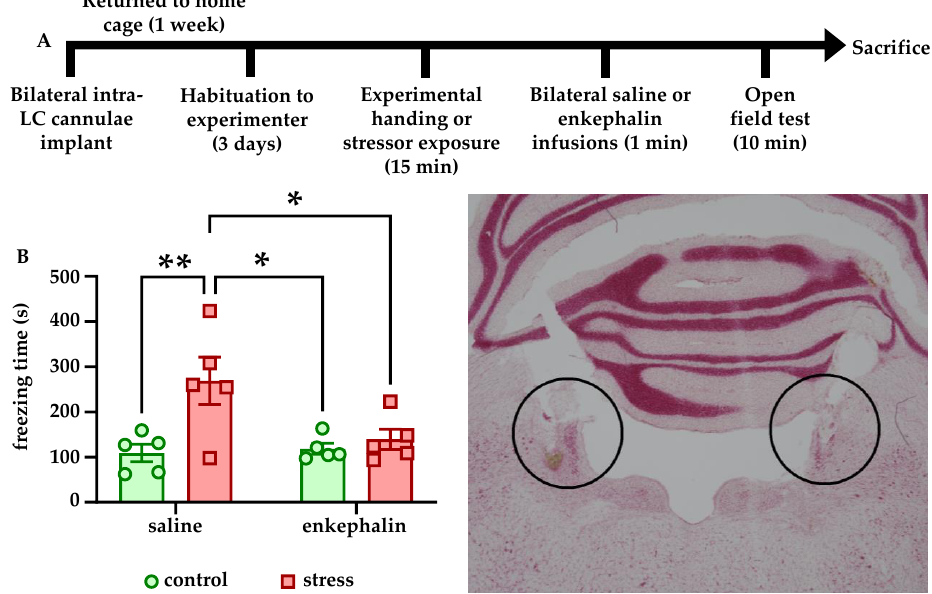
Figure 3. Intra-LC infusions of enkephalin block stress-induced freezing. The experimental timeline is shown in ( A ). Rats were habituated to handling by the experimenter for 3 days but were naïve to the behavioral apparatus when testing began. Rats that received saline infusions into LC froze in the OFT significantly more than control rats that received saline infusions, and more than control or stressed rats that received enkephalin infusions. Stressed rats that received enkephalin infusions did not freeze more than control rats that received enkephalin infusions ( B ). A representative photomicrograph showing bilateral cannulae placement within LC is shown in the bottom right. * p < 0.05; ** p <